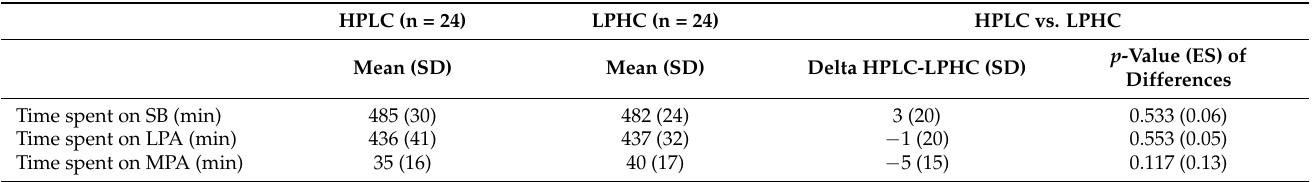
Table 4. Free living sedentary behaviors and physical activity during day 4 in response to HPLC